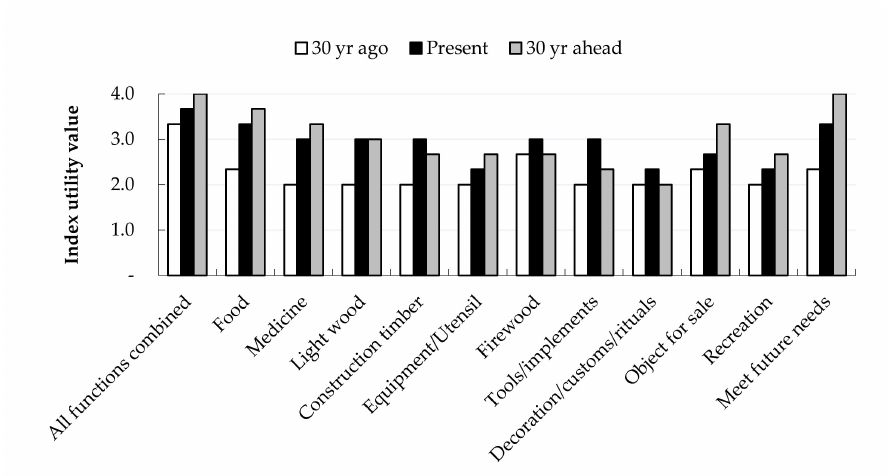
Figure 6. The utility value of cacao-based agroforestry systems based on its products 30 years ago, currently, and 30 years ahead based on farmer